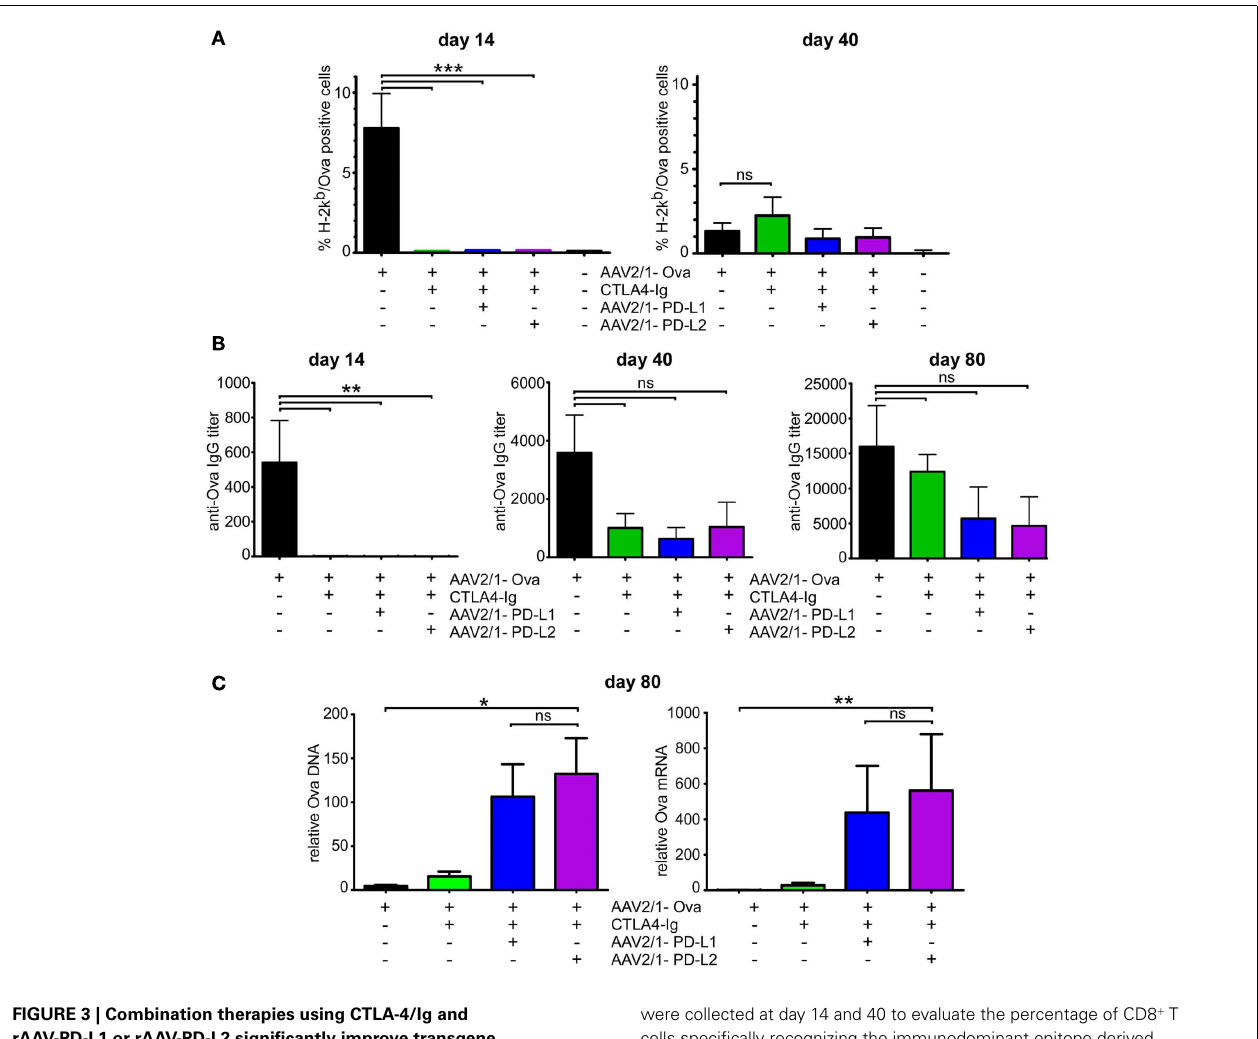
were collected at day 14 and 40 to evaluate the percentage of CD8 + T cells specifically recognizing the immunodominant epitope derived from Ova by flow cytometric analyses. (B) Sera were collected at days 14, 40, and 80 to assay the level of anti-Ova IgG antibodies by ELISA. (C) Injected gastrocnemius muscles were collected at day 80 and analyzed for the presence of Ova DNA and mRNA by qPCR and qRT-PCR